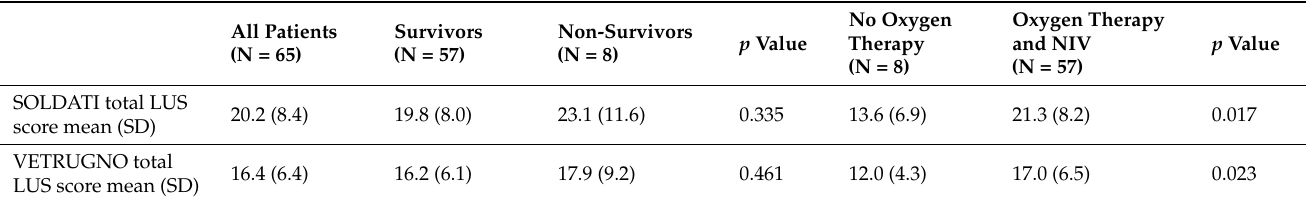
Table 4. Lung ultrasound (LUS) findings at baseline in survivors vs. non-survivors and in patients treated vs. patients not treated with oxygen